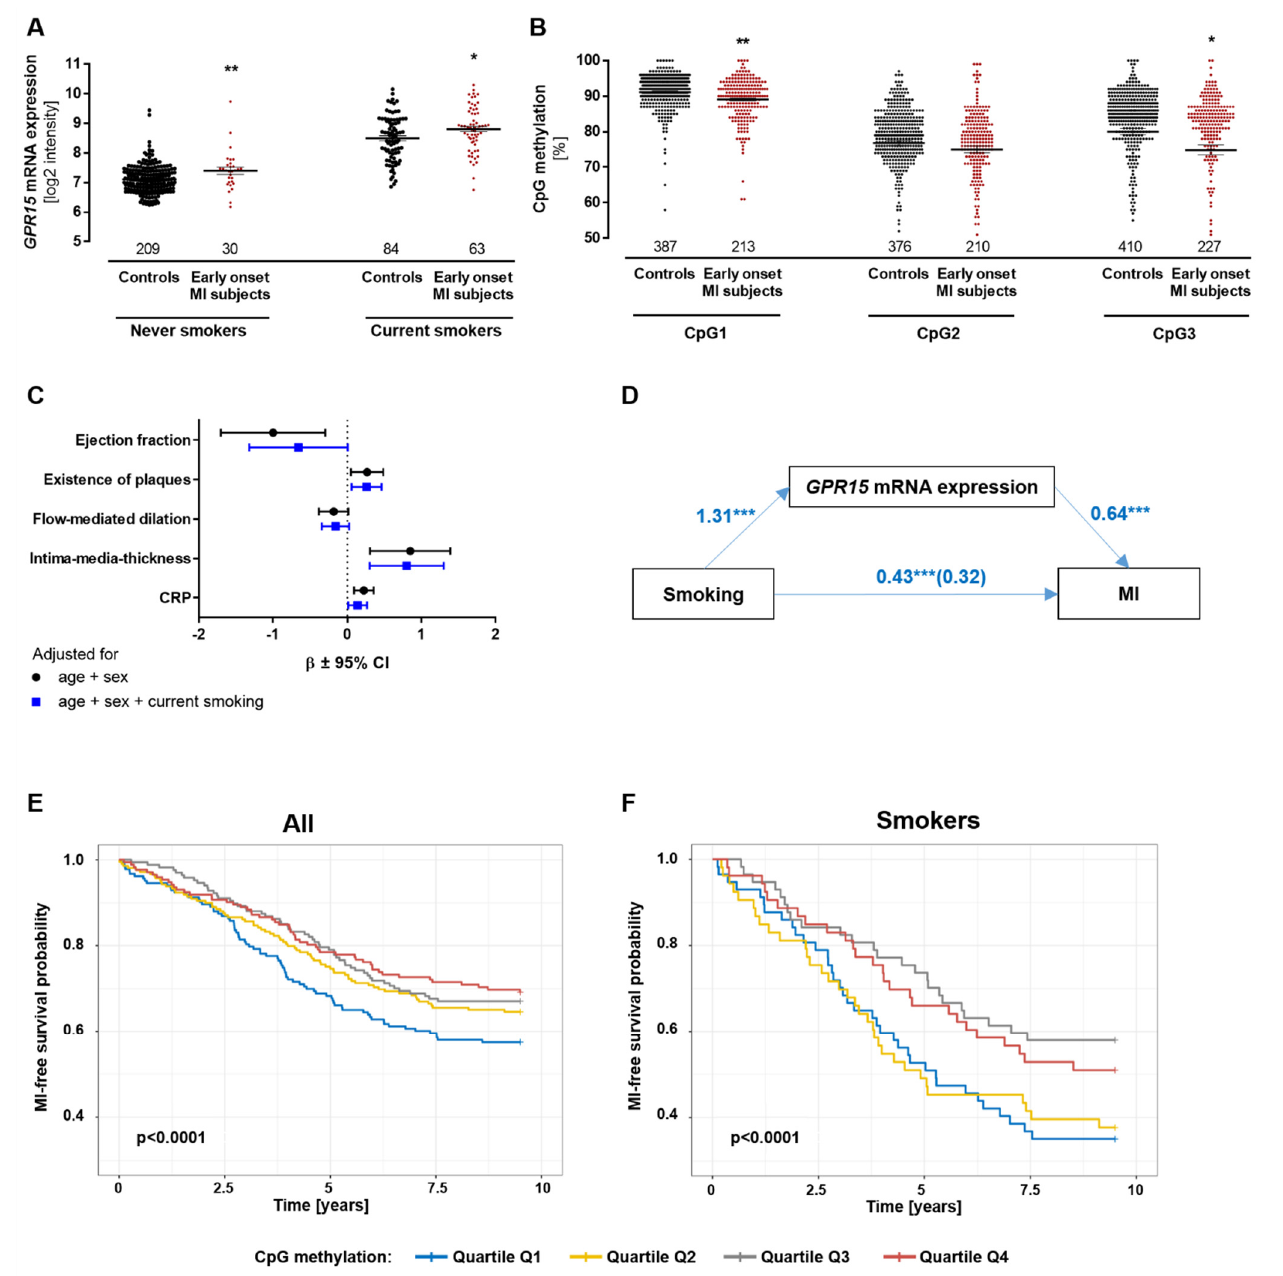
Figure 3. Risk for myocardial infarction predicted by GPR15 DNA methylation independent of smoking status. ( A ) In the GIS discovery cohort, early-onset MI subjects showed significantly higher GPR15 mRNA expression levels in BPMCs compared to controls, independent of smoking status.